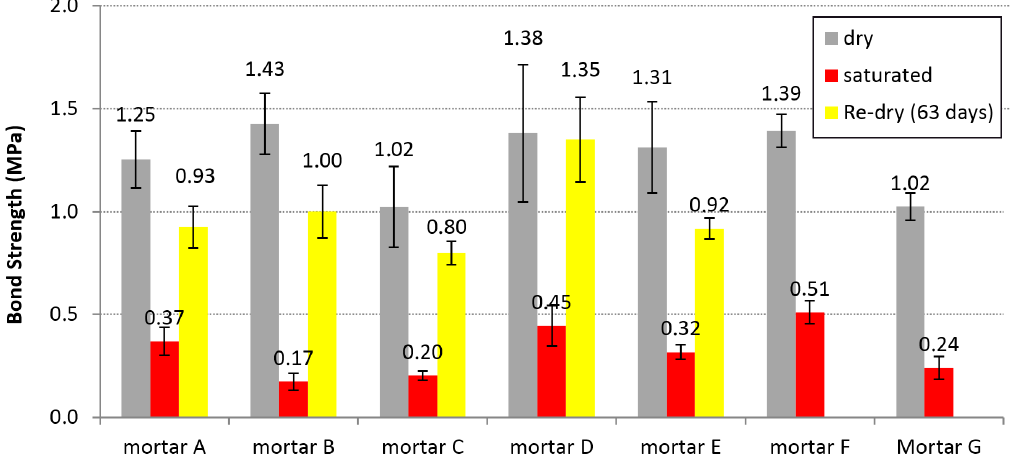
Figure 3. Average bonding strength results for different mortars after dry-curing (dry, 28 days), 10 days of immersion (wet, 38 days) and after 25 days of drying (Re-dry, 63 days).